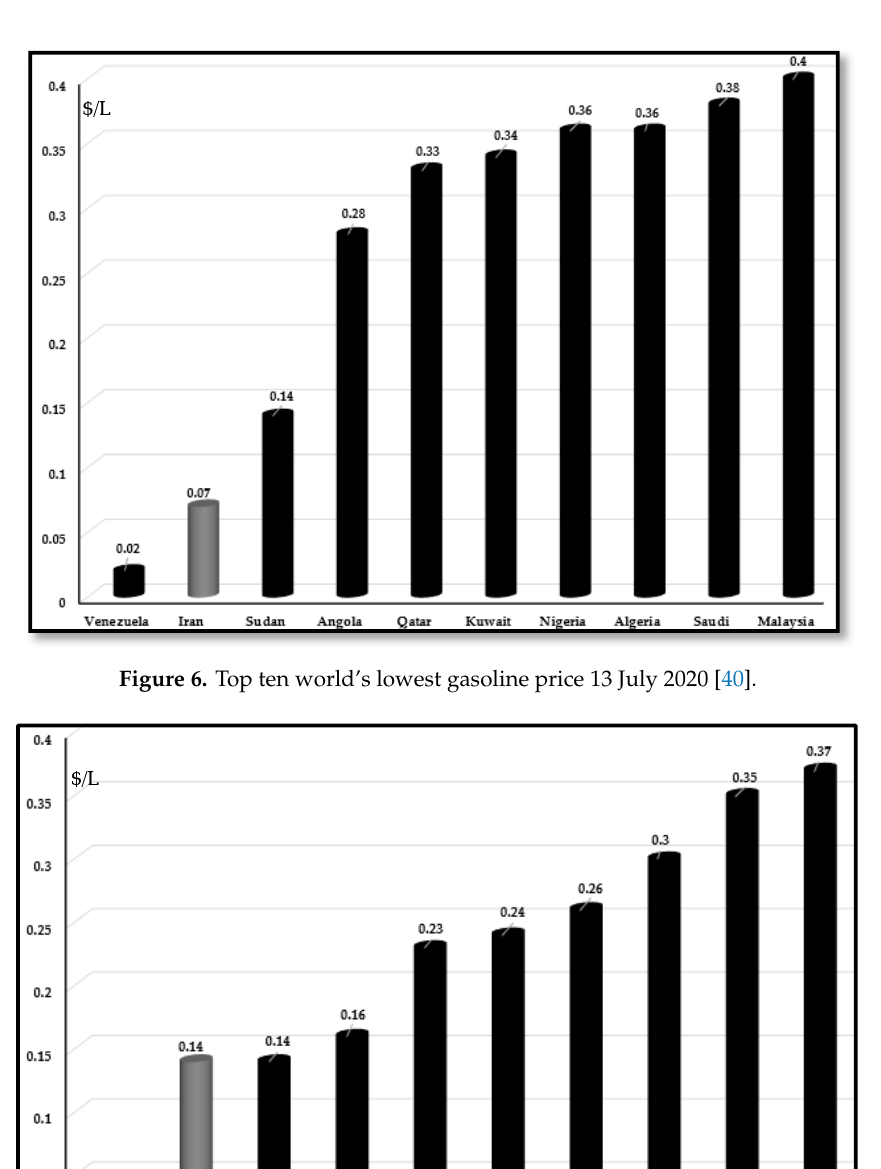
Figure 5. Response of LCO 2 to RES using structural VAR factor.